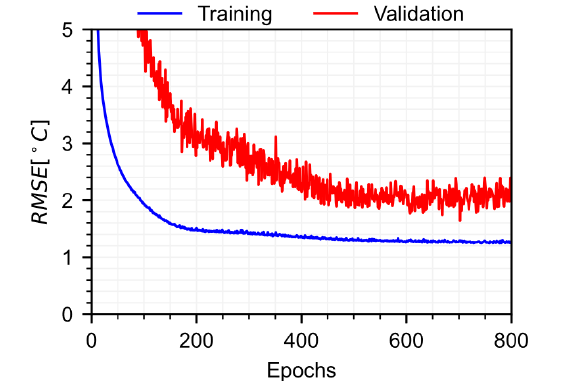
Figure 5. Training and validation losses for the temperature model.